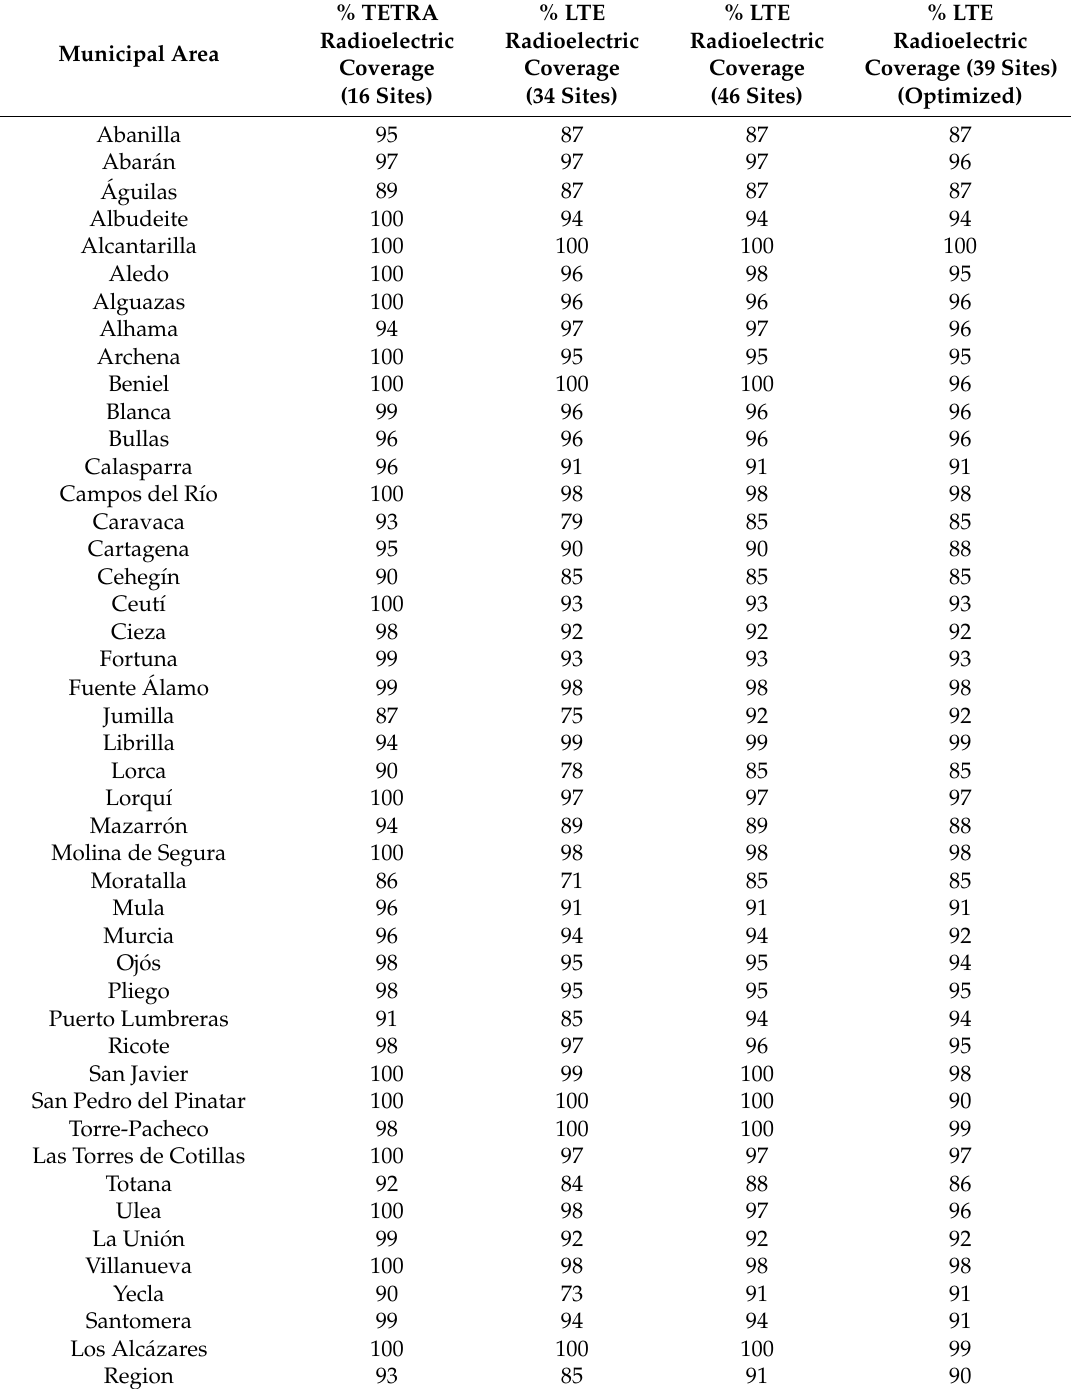
Table 4. Percentage of radioelectric coverage in municipal